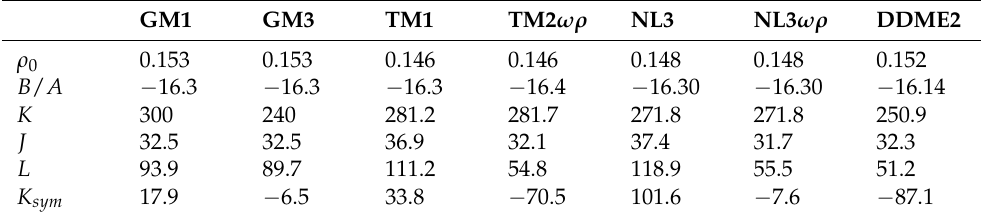
Table 1. Nuclear properties at saturation number density ( ρ 0 (fm − 3 )) predicted by seven kinds of EoSs used in this study [20,28]: energy per nucleon ( B / A (MeV)), incompressibility ( K (MeV)), symmetry energy ( J (MeV)), its slope parameter ( L (MeV)), and curvature ( K sym (MeV)) at the saturation point of uniform symmetric nuclear matter [29].